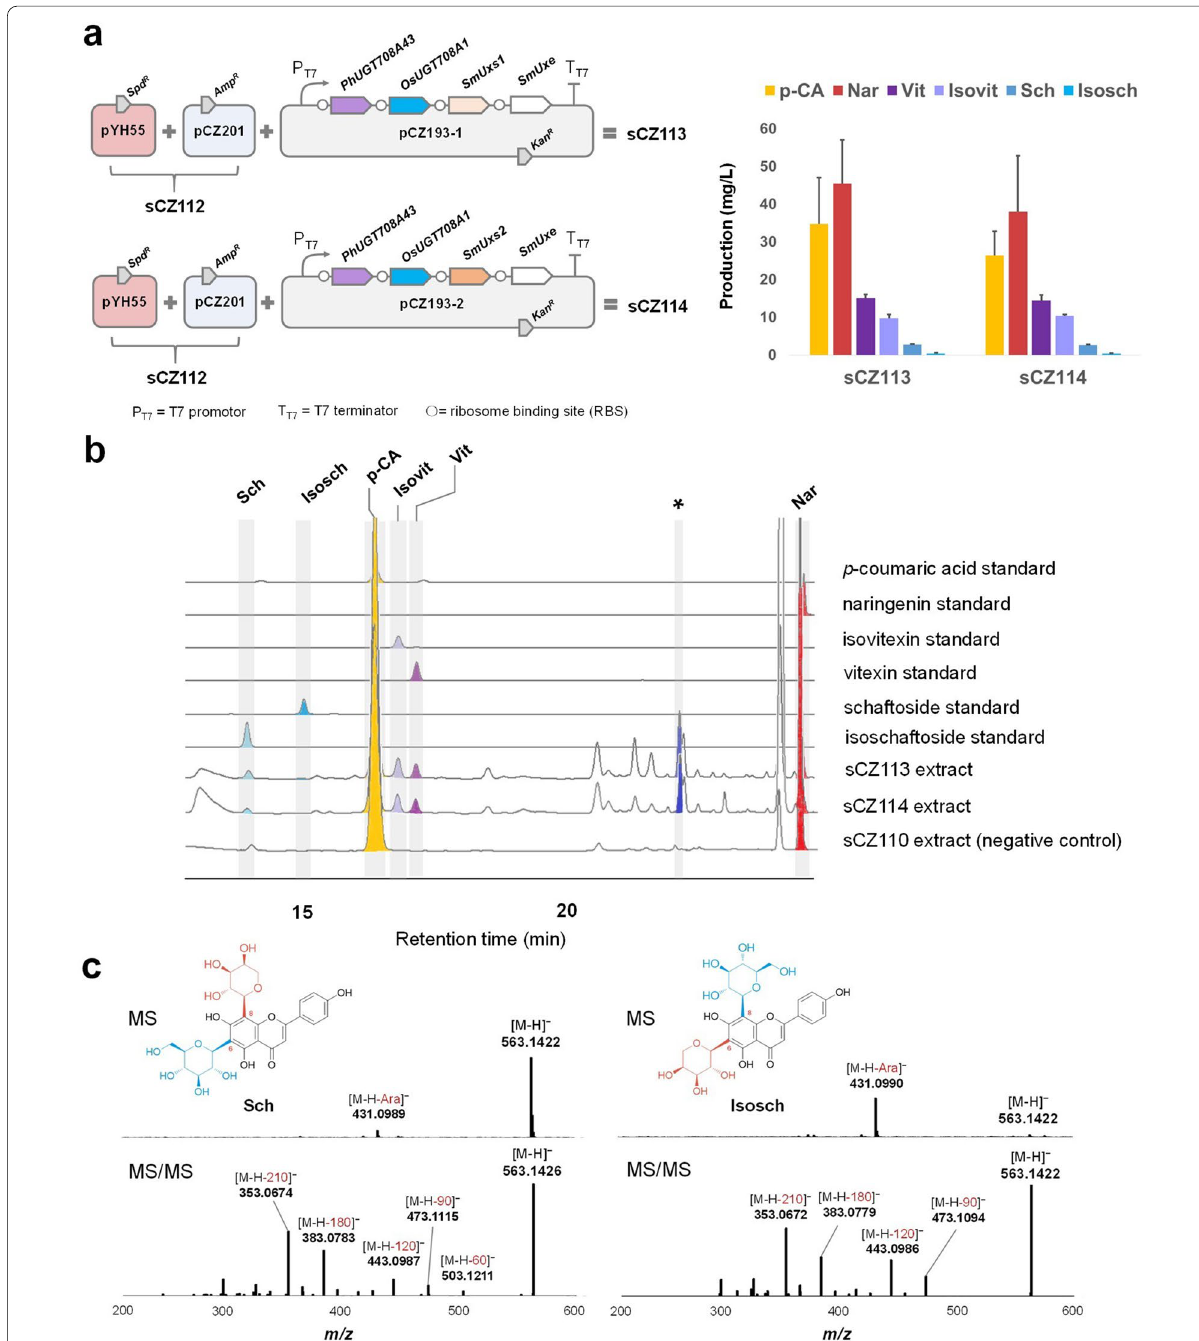
Fig. 3 De novo biosynthesis of schaftoside. a Reconstitution of schaftoside pathway in E. coli chases. pYH55 (Li et al. 2019) is assembled for naringenin (Nar) production and pCZ201 (Sun et al. 2020) harbors cytochrome P450 module for 2-hydroxylnaringenin (2-OHNar) production. Fermentation of sCZ113 and sCZ114 revealed similar productivity. b HPLC chromatography of the extract of sCZ113. Standard samples were also analyzed for comparison. The peak indicated in asterisk was temporarily identified as apigenin 6(8)- C -arabinoside. UV absorbance at 280 nm was monitored. ( C ) MS and MS/MS spectra of schaftoside (Sch) and isoschaftoside (Isosch) present in the extract of